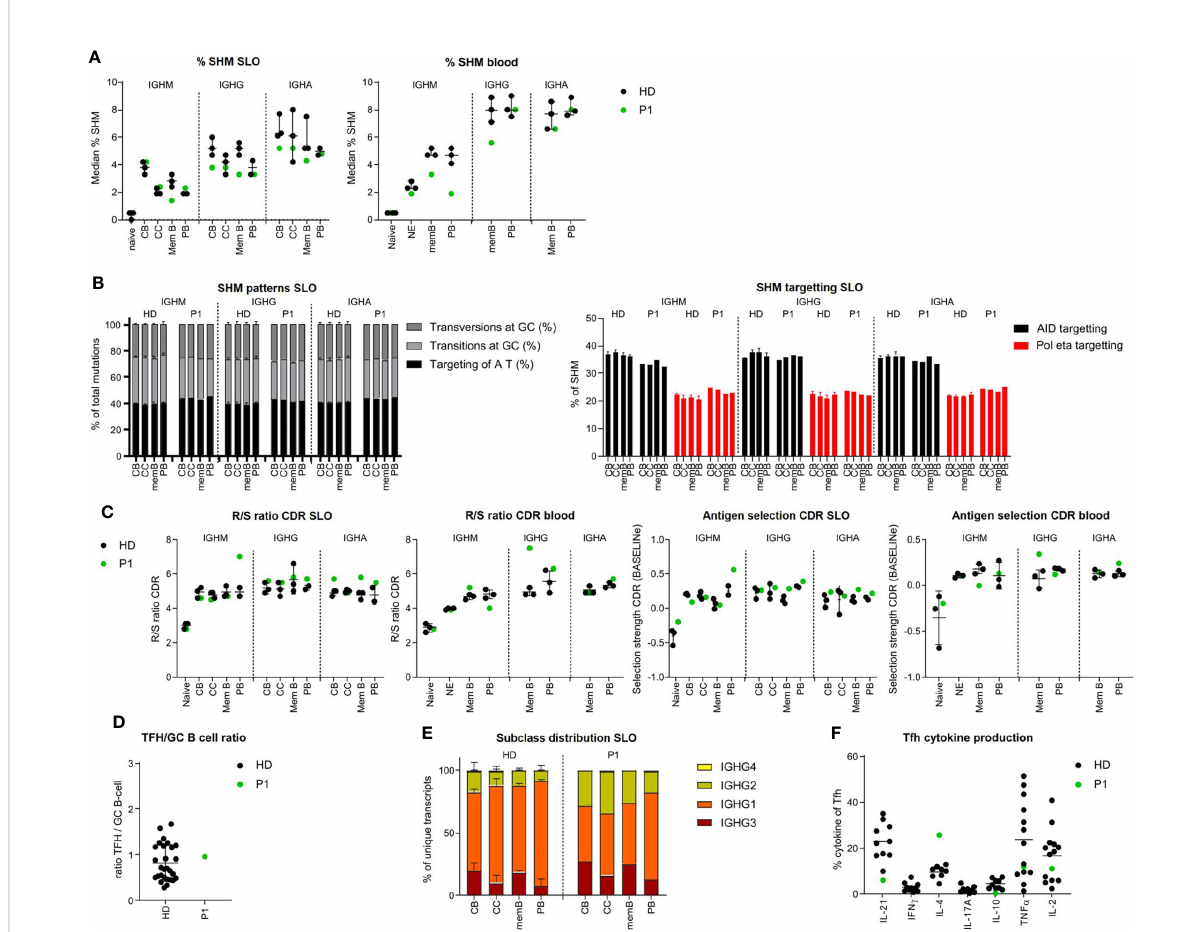
FIGURE 2 BCR repertoire analysis shows minor differences in BCR speci fi cation in the tonsil and blood of P1. (A) Median percentage of SHM in BCR transcripts of sorted B-cell populations. (B) SHM patterns and targeting in sorted B-cell populations. (C) Evaluation of antigen selection in sorted B-cell populations. (D) Tfh/B-cell ratio in the tonsil. (E) Subclass distribution in IGHG transcripts of sorted tonsil populations. (F) Cytokine production of Tfh